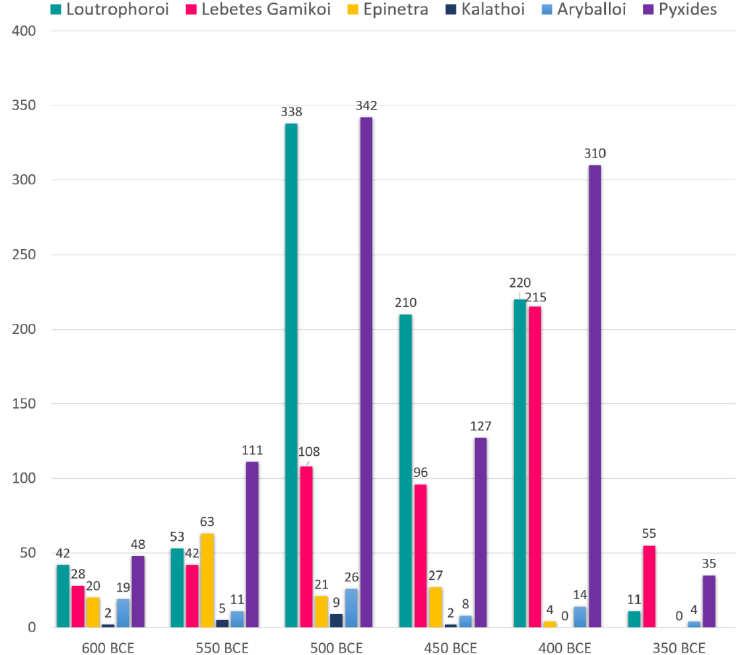
Figure 7. Relative numbers of Athenian vase-paintings featuring women in the imagery grouped by approximate dates. Data from the BAPD. Please note that lekythoi are not included on this chart as they are much more numerous than the other shapes and would distort this chart. Chart created by author.